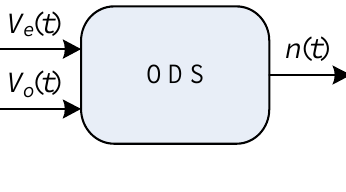
Figure 9. Instantiated object dynamic system (ODS) object composed of two inputs, P = 2 ( t ) , and control of the output valve, V (control of the input valve, V e H = 1 (level of water in the tank, n ( t )